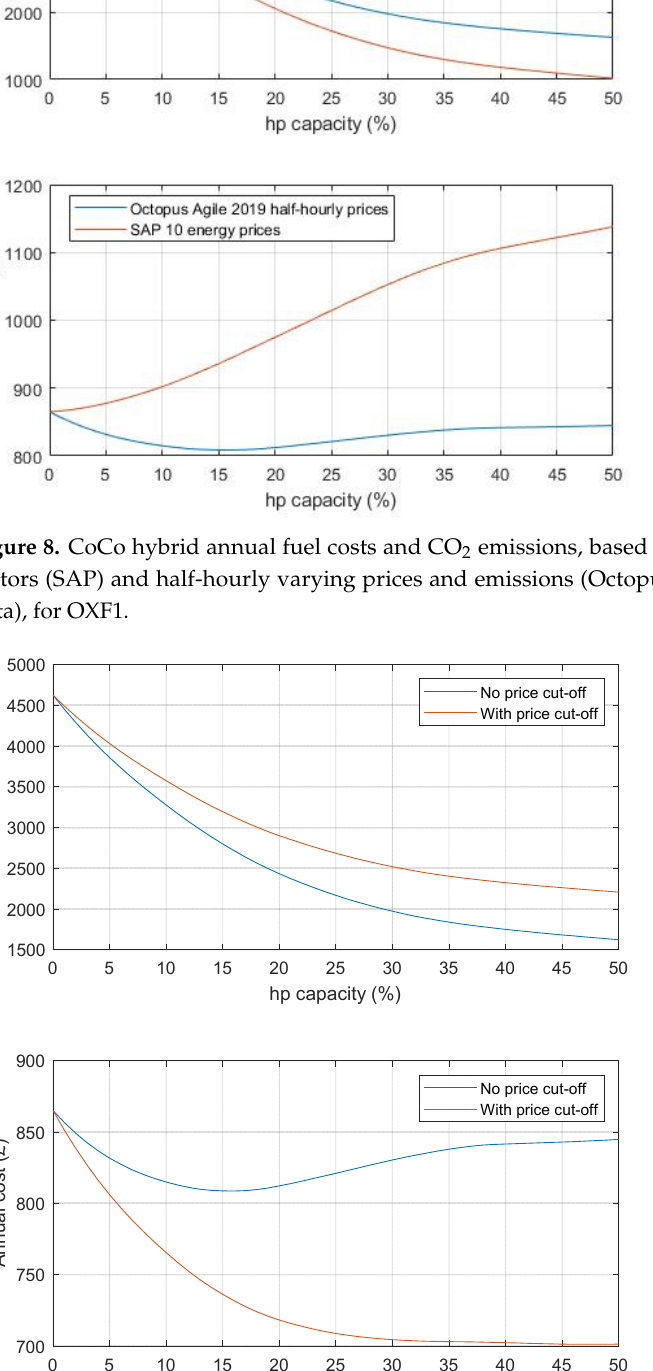
Table 3. Cost and CO 2 results for hybrid heat pump of various sizes in OFX1 and OXF2. Results are given without a price cut ‐ off, using SAP 10 prices and emission factors and actual 2019 Octopus Agile and 2019 half ‐ hourly grid emission factors. Results are also given for the case where the HP does not switch on when the price is over £0.20/kWh for electricity, based on Octopus Agile 2019 and actual 2019 half ‐ hourly grid emissions. House ‐ Sce ‐ nario